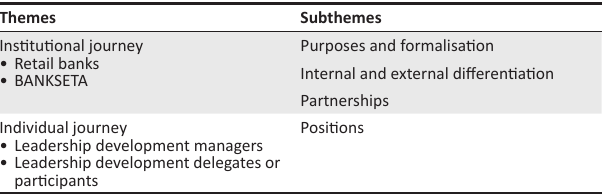
TABLE 1: Themes and subthemes.